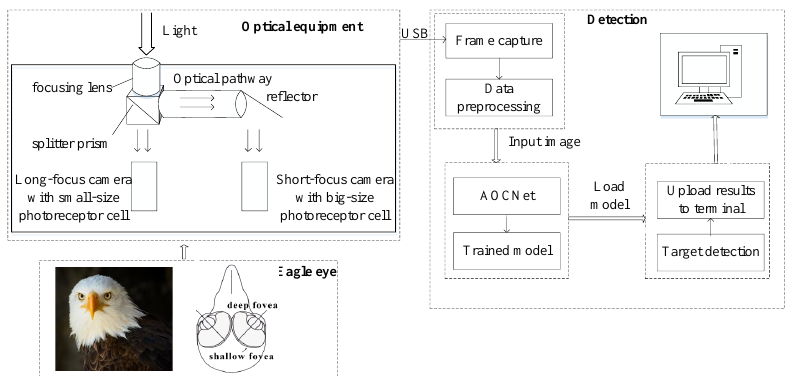
Figure 5. The schematic diagram of optical imaging. Long-focus camera (The central part of